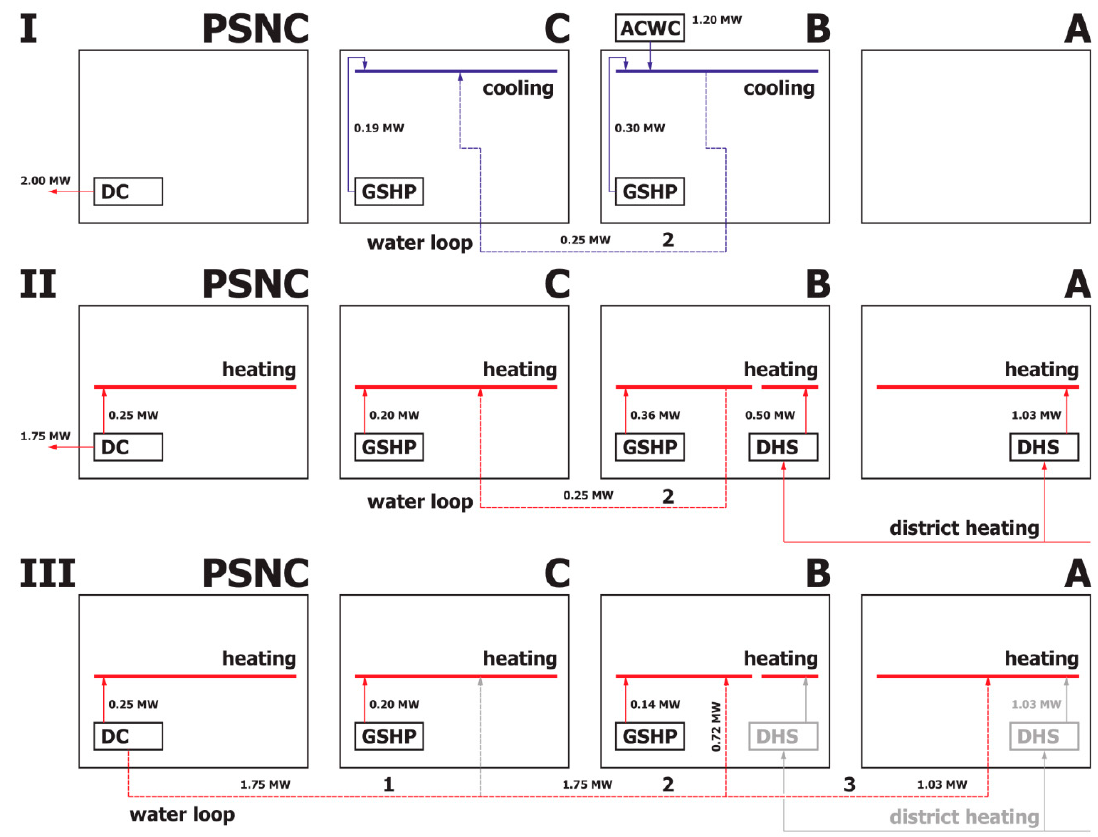
Figure 3. Main heat fluxes for PSNC and PUT A, B and C buildings, ( I )—summer period, ( II )—winter period with water loop #2, ( III )—winter period with #1, #2 and #3 loops, DHS—district heating substation, ACWC—air cooled water chiller.